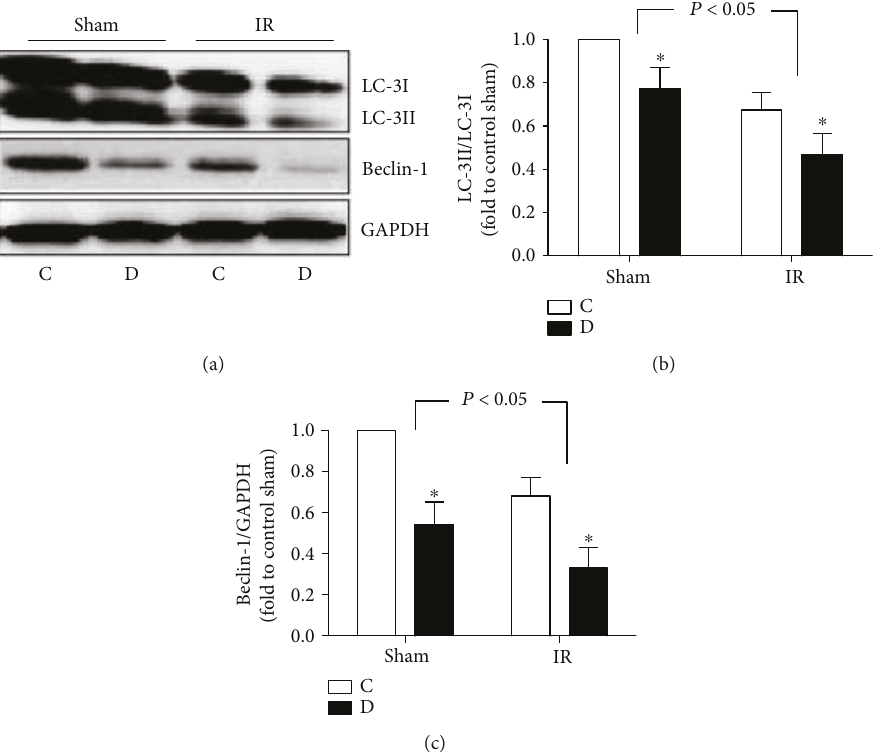
Figure 3: Expression of LC-3II and Beclin-1 in pulmonary tissues form control (C) and diabetic (D) rats subjected to sham or myocardial ischemia reperfusion (IR) operation. (a) Representative Western blot demonstrating LC-3II, LC-3I, and Beclin-1 expression with GAPDH as loading control. (b) LCII/LCI ratio were calculated by relative densitometric values and expressed as fold to control sham group. (c) Beclin-1 express were calculated by relative densitometric values and expressed as fold to control sham group. All values are expressed as mean means ± S.D., n = 8 . ∗ P < 0 05 versus the corresponding C group.